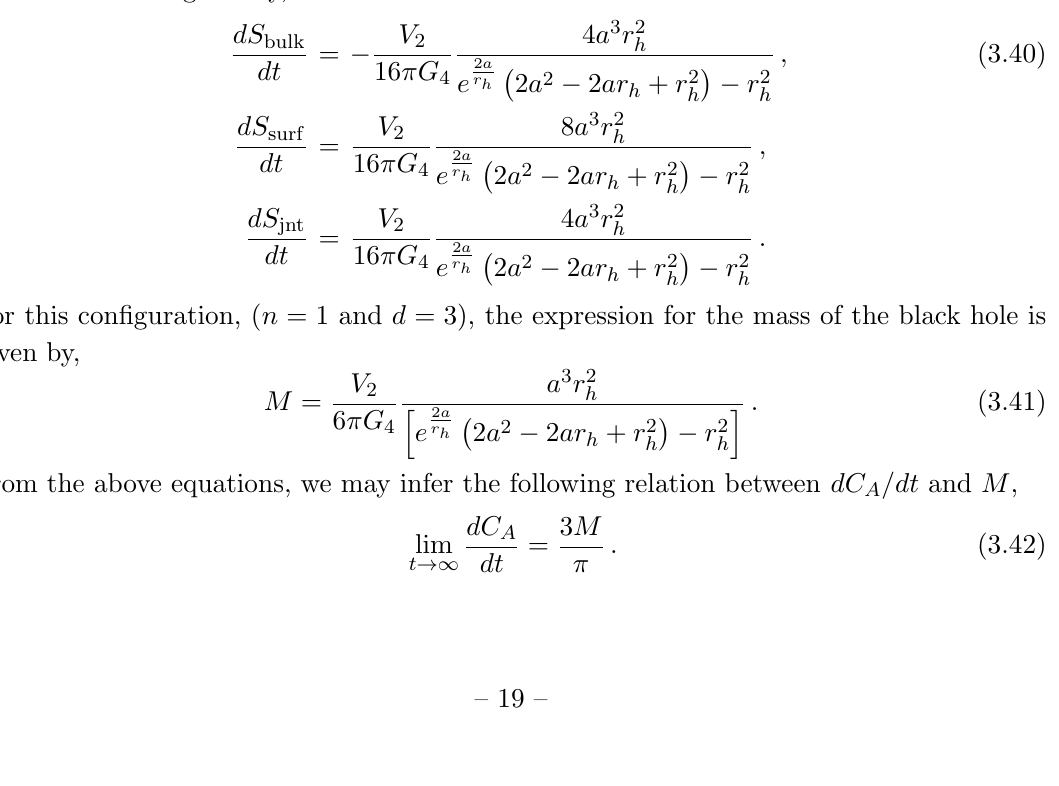
for r h = 1 : 0, (b) for r h = 1 : 5 and for dt dC A = 1. The values of 8 M dt